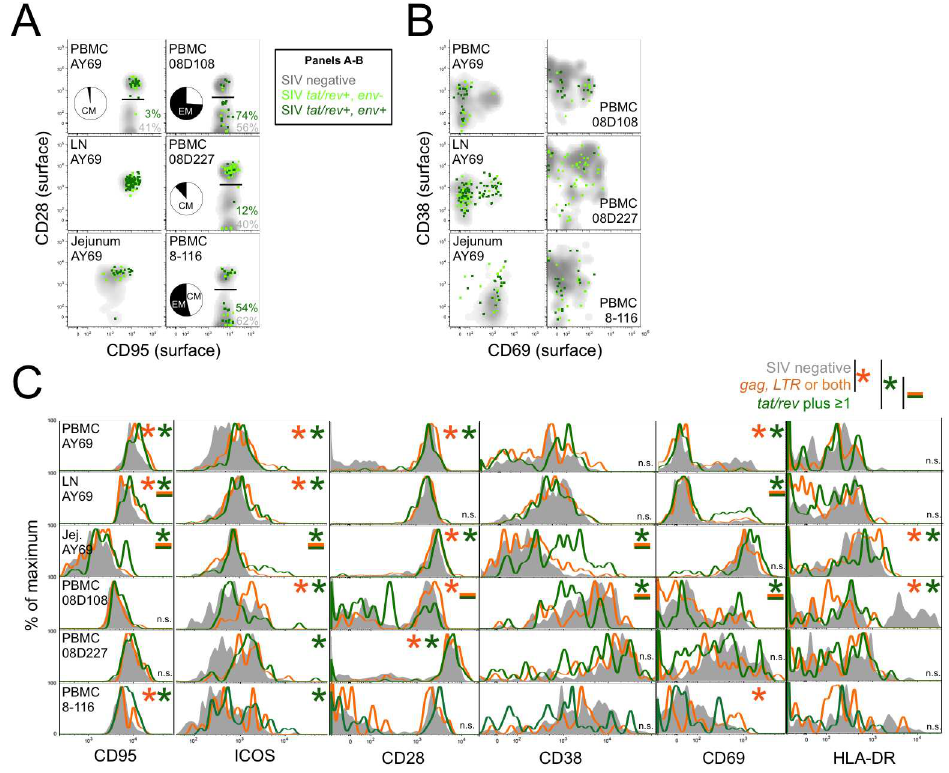
Fig 4. Surface phenotype of in vivo SIV-infected CD4 T cells. (A) Memory differentiation status of tat/rev + infected cells. CD28 and CD95 surface protein expressionby tat/rev + cells (green) is overlaidatop the profile of SIV negativecells (gray). The percentage of cells negativefor CD28 is indicatedfor each population. Inset pie charts depict the proportionof tat/rev + cells that are central (CM; white) and effector memory (EM; black). See also S4 Table. (B) Surface stainingfor activationmarkers, CD38 and CD69, is shown for tat/rev + cells. (C) Surface protein expressiondistributionof CD95, ICOS, CD38, CD69, and HLA-DRby uninfected(gray), gag + and/or LTR + (orange;early, latent or abortive infection), and tat/rev + (green) cells. Significantdifferences were determinedby ANOVA across the three populations(p < 0.05)followedby Student’s t-test between populations (p < 0.05, * ). Experiments were performed once for each specimen(n = 6) and all data is